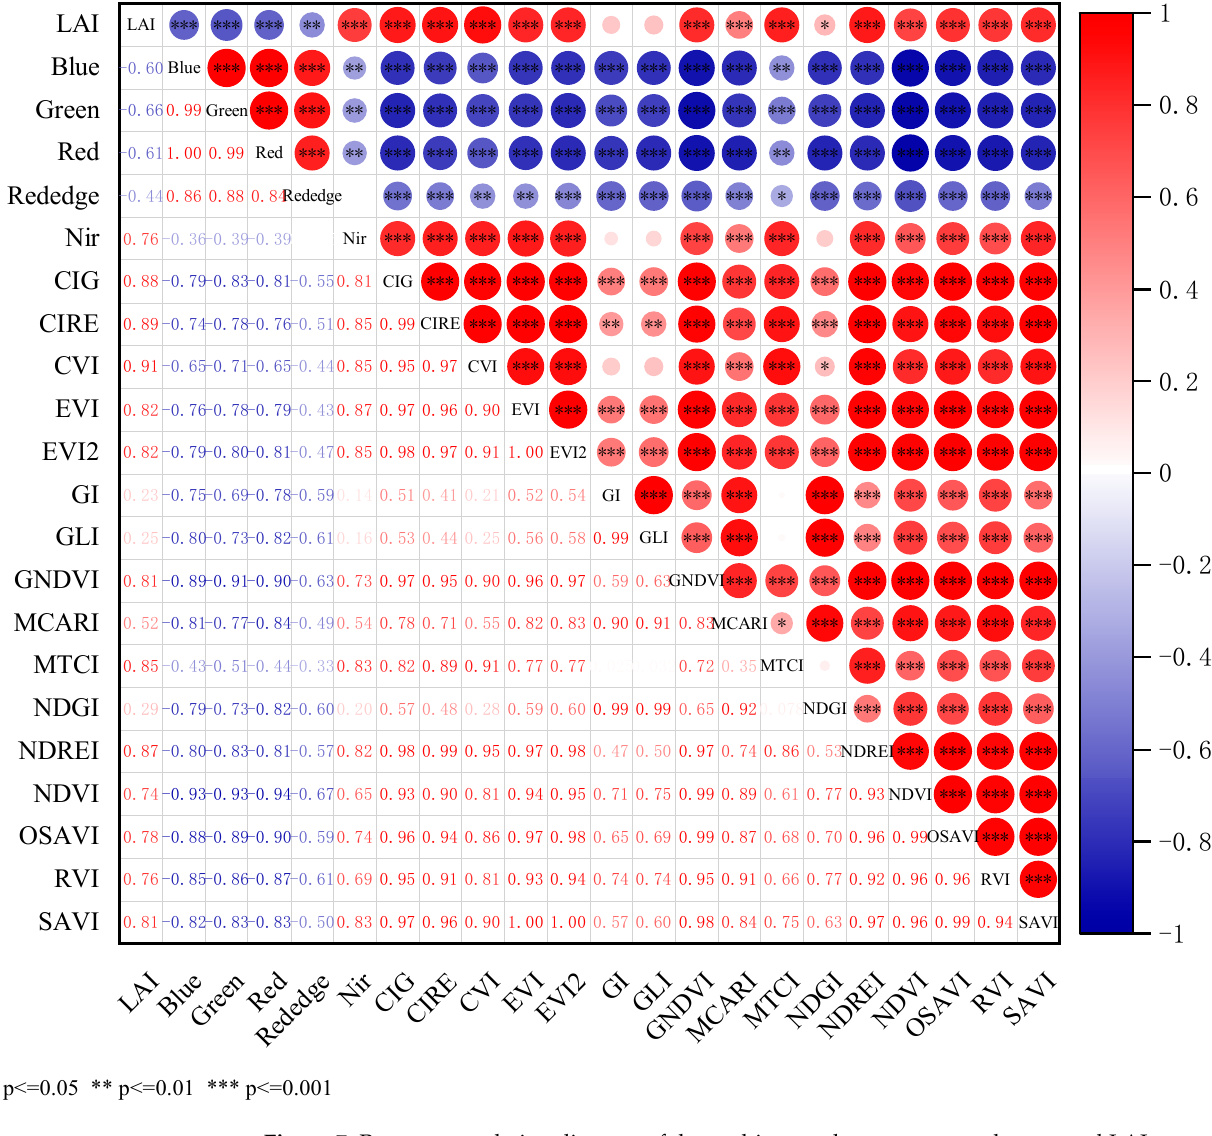
Figure 7. Pearson correlation diagram of the multispectral parameters and measured LAI.